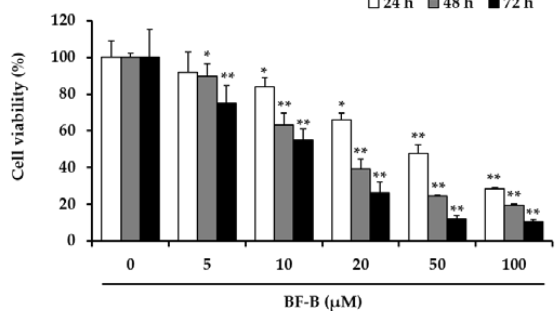
Figure 2. Effect of BF-B on growth of PANC-1 cells. PANC-1 cells were treated with BF-B at 0, 5, 10, 20, 50, and 100 μM, for 24, 48, or 72 h, and cell viability was assessed by MTT assay. All data are